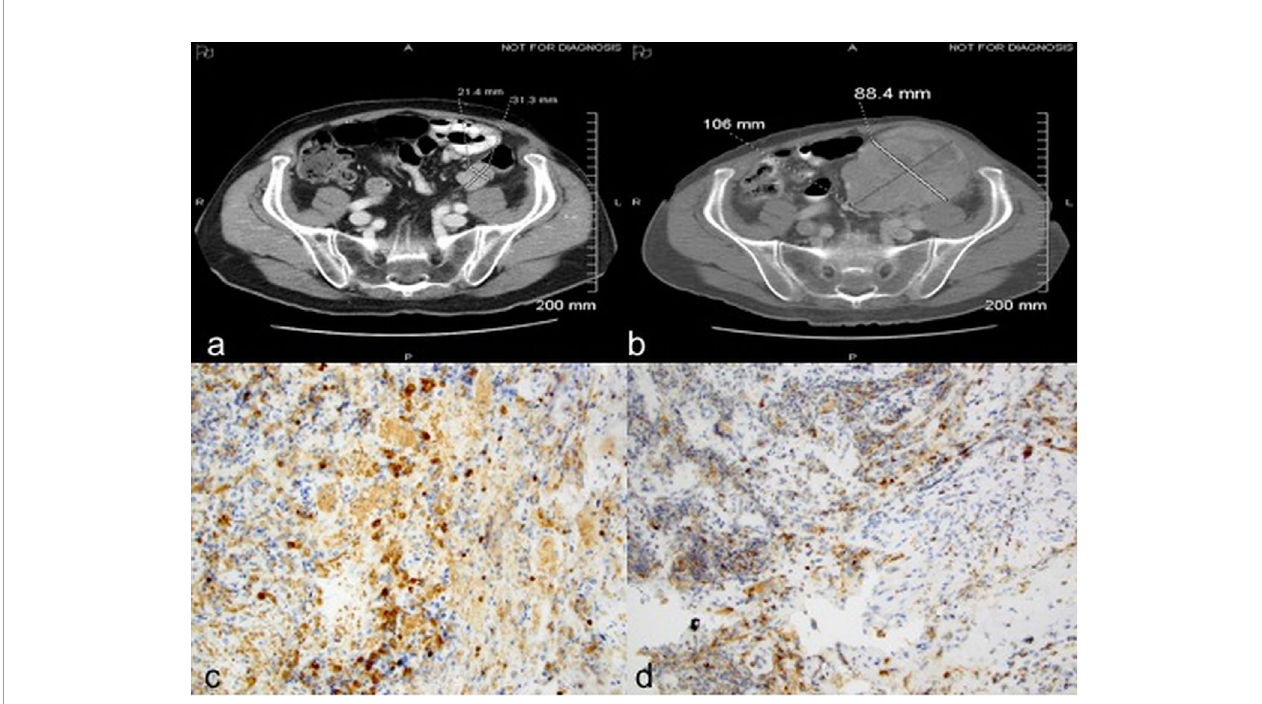
FIGURE 2 | Case 2 demonstrating descending colon mass before (A) and after (B) nivolumab treatment; (C) CD4 positive (D) CD 68 positive immunohistochemical